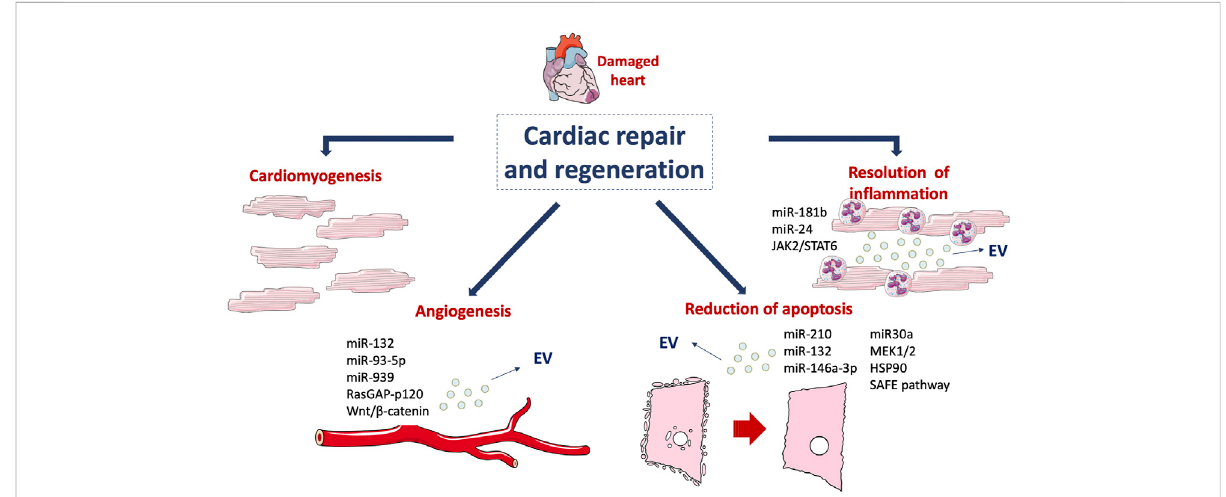
FIGURE 2 Mechanisms involved in cardiac regeneration. Cardiomyogenesis and EV-mediated effects, such as angiogenesis, reduction of apoptosis and resolution of in fl ammation drive the damaged cardiac tissue towards healing. This fi gure was partly generated using Servier Medical Art